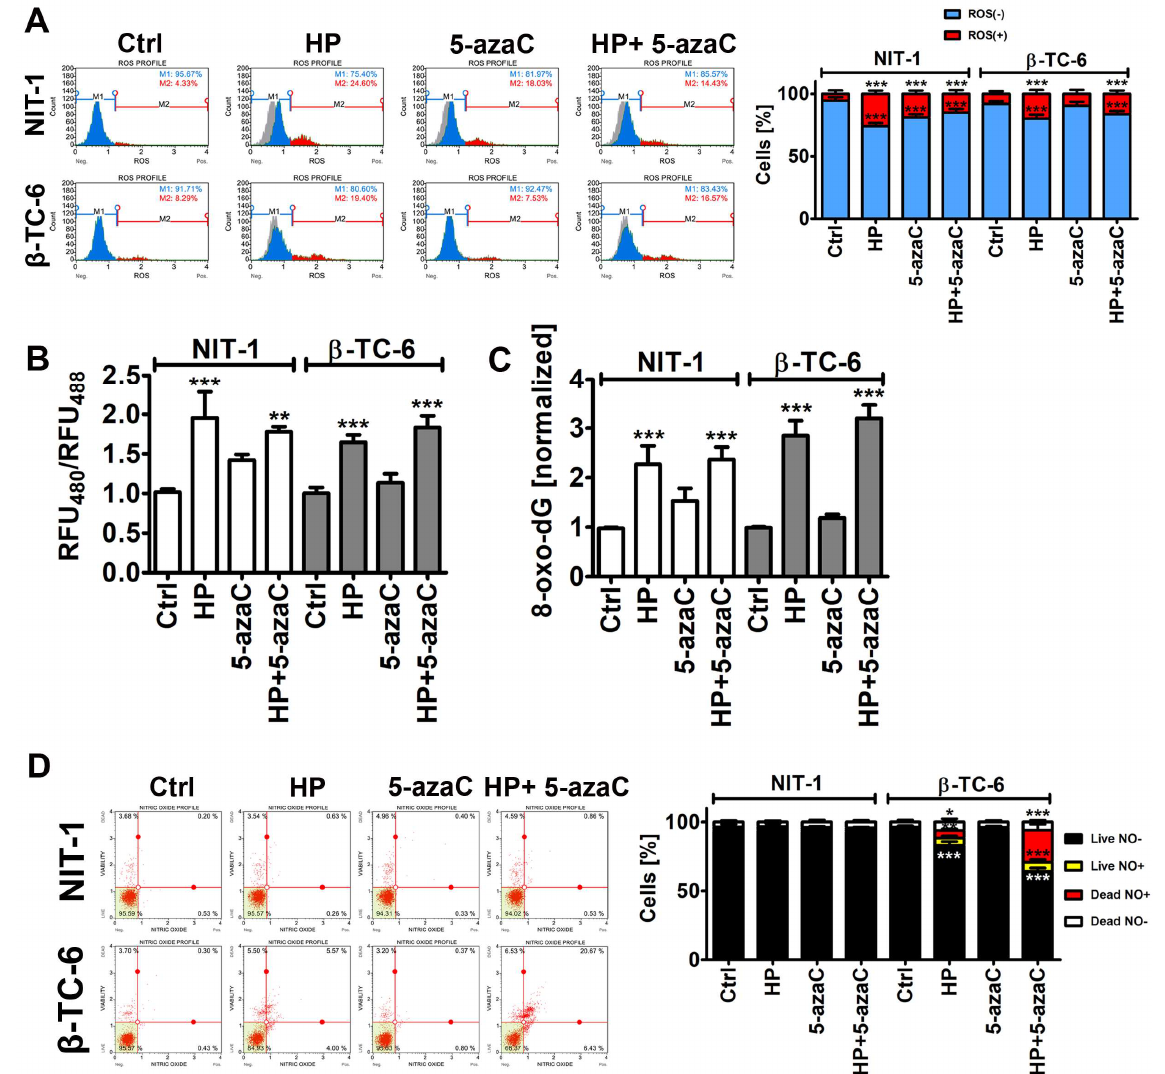
Figure 3. 5-AzaC post-treatment-mediated oxidative stress ( A , B , C ) and nitrosative stress ( D ) in hy- drogen peroxide-treated mouse insulinoma NIT-1 and β -TC-6 cells. Insulinoma cells were stimulated with 100 µ M HP for 24 h and then post-treated with 1 µ M 5-azaC for 24 h. ( A ) Superoxide levels were analyzed using dihydroethidium (DHE) staining and flow cytometry. Representative histograms are shown. A gray control histogram (Ctrl) is overlayed on each sample. Two subpopulations were considered and quantified [%], namely superoxide-negative subpopulation (blue) and superoxide-positive subpopulation (red). Bars indicate SD, n = 3, *** p < 0.001 compared to Ctrl (ANOVA and Dunnett’s a posteriori test). ( B ) The glutathione redox potential was analyzed using roGFP-Grx1 redox sensor according to the manufacturer’s instructions. The data are presented as a ratio of fluorescent measurements (relative fluorescent unit, RFU) at 400 nm and 488 nm. Bars indicate SD, n = 3, *** p < 0.001, ** p < 0.01 compared to Ctrl (ANOVA and Dunnett’s a posteriori test). ( C ) The levels of 8-hydroxy-2′-deoxyguanosine (8-oxo-dG) in total DNA were measured using dedicated enzyme- linked immunosorbent assay (ELISA). The data were normalized to Ctrl. Bars indicate SD, n = 3, *** p < 0.001 compared to Ctrl (ANOVA and Dunnett’s a posteriori test). ( D ) Nitric oxide levels were analyzed using DAX-J2 TM orange staining and flow cytometry. Bars indicate SD, n = 3, *** p < 0.001, ** p < 0.01, * p < 0.05 compared to Ctrl (ANOVA and Dunnett’s a posteriori test). Representative dot plots are shown. Ctrl, control conditions; HP, hydrogen peroxide (H 2 O 2 ) treatment; 5-azaC, azacytidine treatment; HP+5-azaC, hydrogen peroxide treatment, and azacytidine